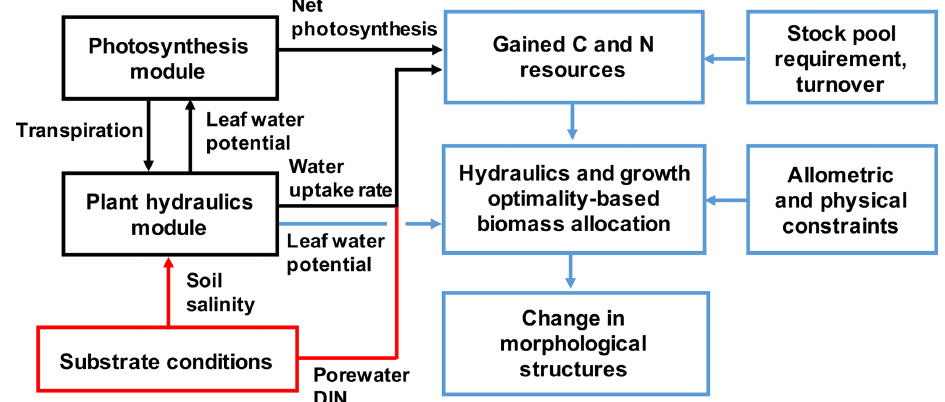
Figure 2. The model framework newly added to SEIB-DGVM for describing mangrove growth. The red box and arrows indicate the substrate conditions given in the model. The black boxes and arrows indicate processes computed in the hourly time steps, while the blue ones are for the daily time step. Table 1. Parameters constraining plant morphology, biomass proportion, and stoichiometry. Type of